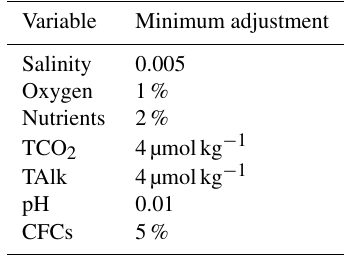
Figure 2. Number of cruises per year in GLODAPv2 and GLO- DAPv2.2019.